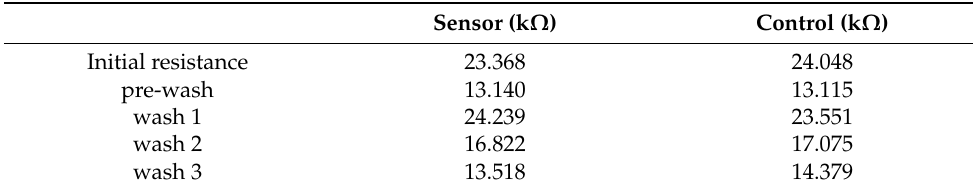
Table 2. Resistance values for negative control shown in Figure